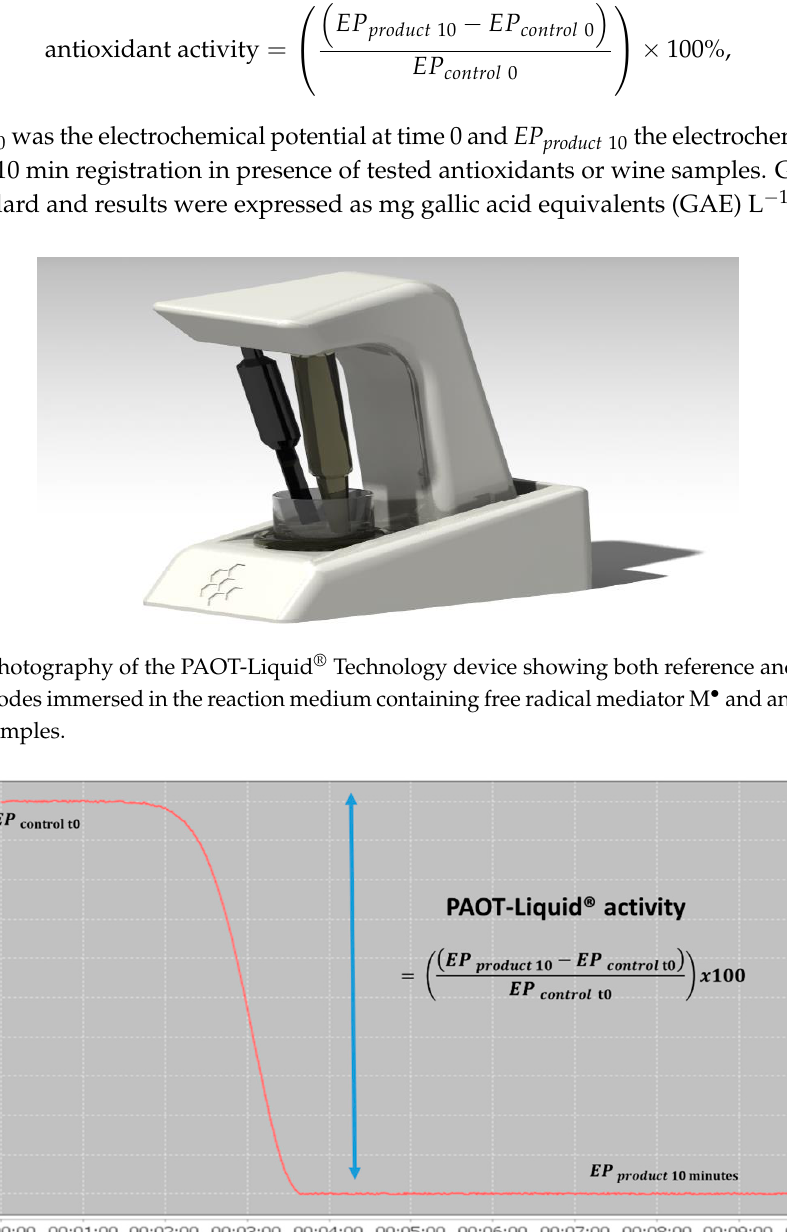
Table 1. Characteristics of tested wines bought in a Belgian commercial market.